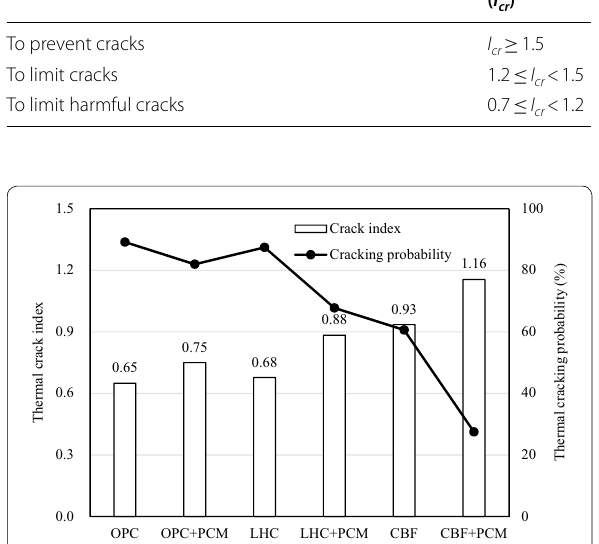
Fig. 10 Thermal crack index and probability of different